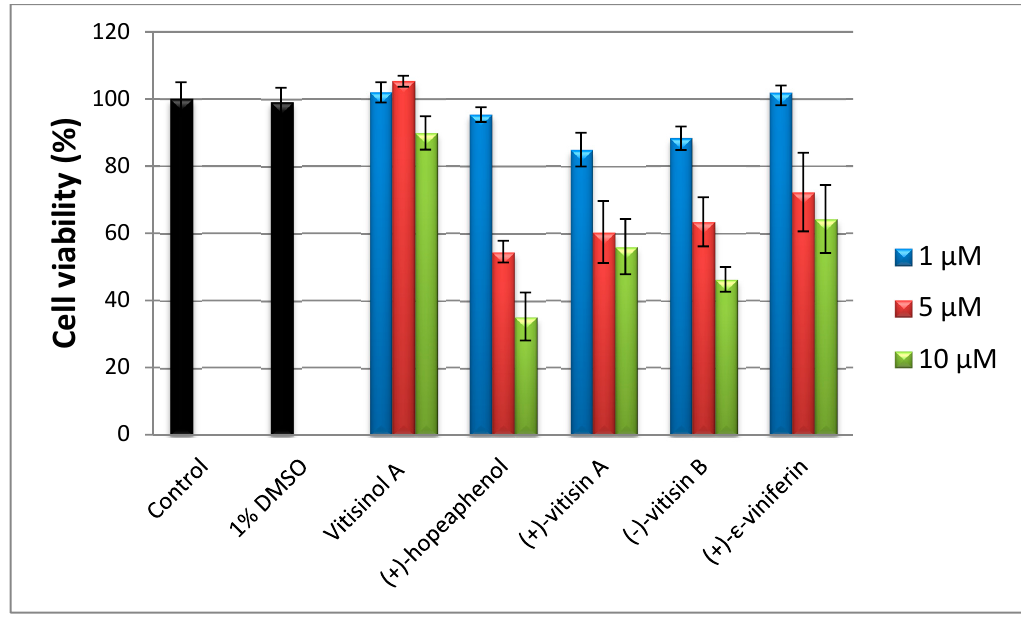
Figure 2. 3-(4,5-dimethylthiazol-2-yl)-2,5-diphenyltetrazolium bromide (MTT) assay of RAW264.7 cells treated with five oligostilbenes at 1.5 and 10 μ M.